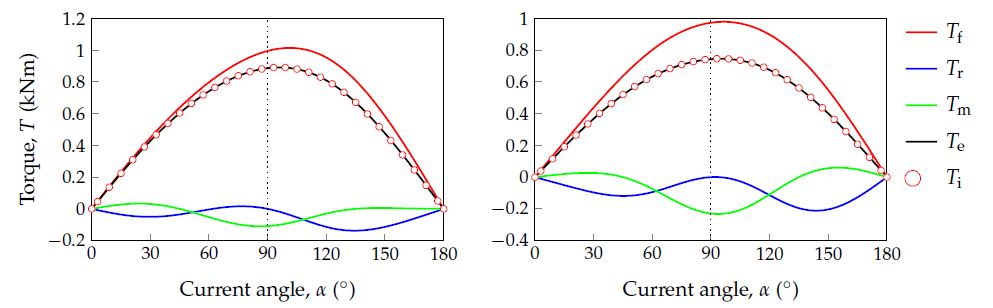
Figure 6. WF-FMM torque characteristics of ( left ) WF-FSM and ( right ) DC-VRM at rated currents (phase and field) and different operating points defined by the current angle.